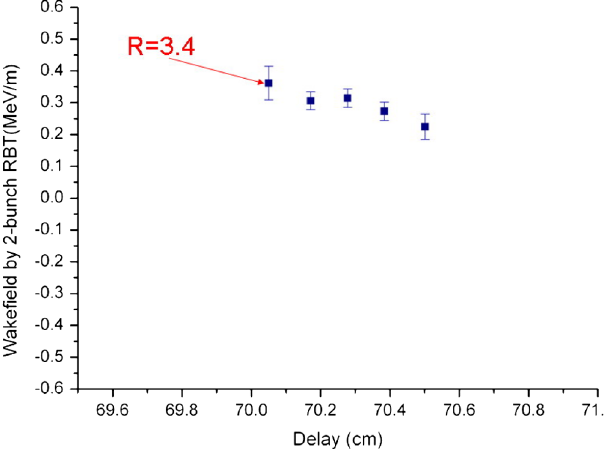
FIG. 8. Measured results of wakefield generated by the two- bunch RBT traversing the 13.625 GHz dielectric accelerator. Data points were obtained by measuring the energy change of the witness bunch at various delays. The maximum transformer ratio measured was 3.4 (marked in the